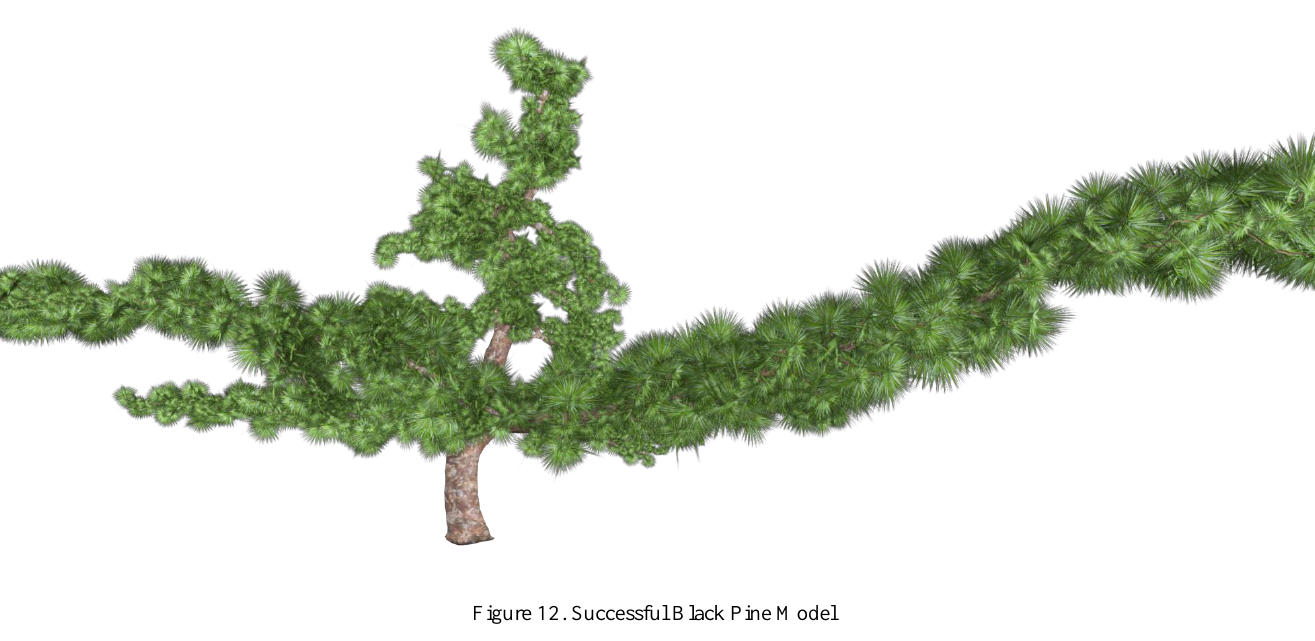
figure - Case of Cryptomeria japonica and Chamaecyparis